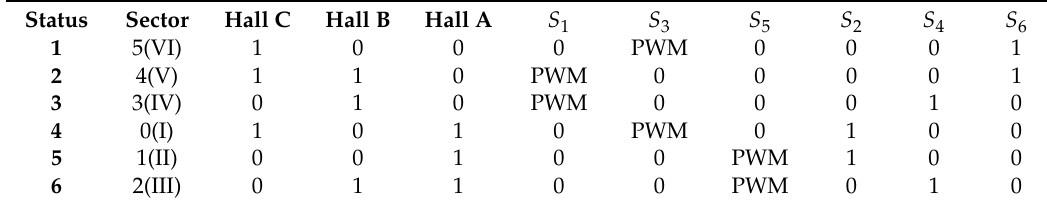
Table 1. Hall table for controlling reverse magnetic field.